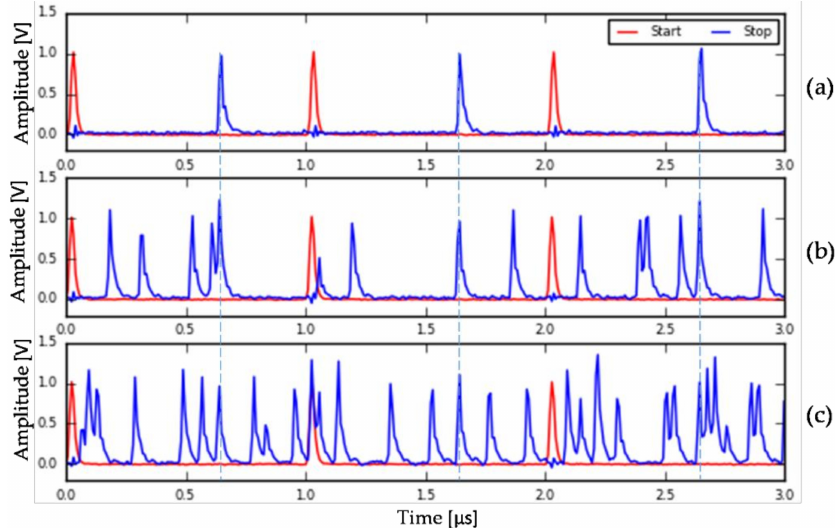
Figure 5. Waveforms are collected under different background noise environmental conditions: ( a ) In the lab room at night; ( b ) in the lab room at night with strong background light; ( c ) outdoor at noon.